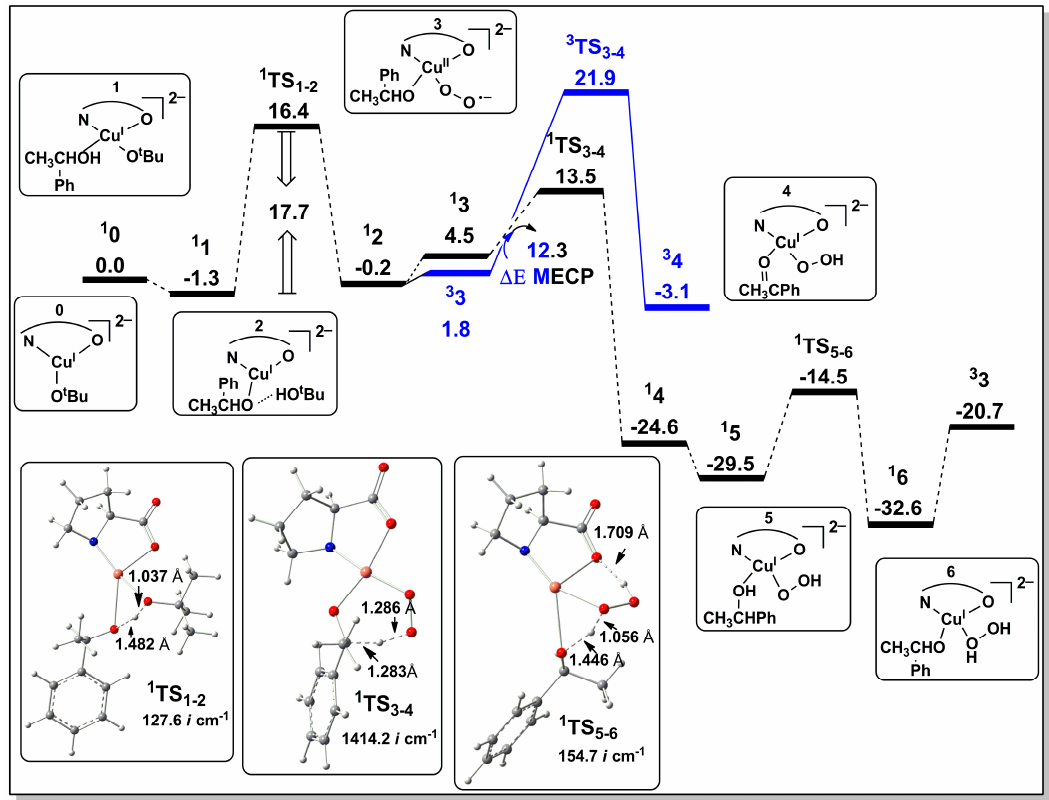
Figure 1. The calculated Gibbs free energy profiles for process 0 → 4 and path A. The solid blue line represents the triplet spin state; the dashed black line represents the singlet state. The energy values are in kcal/mol.